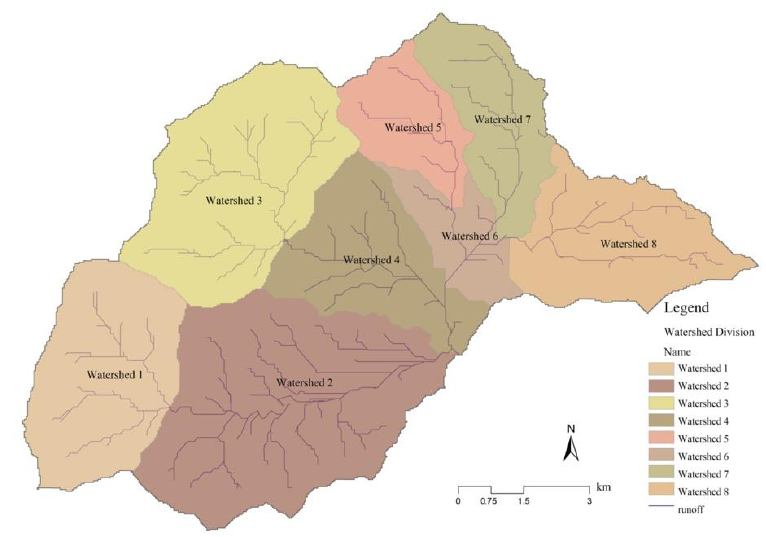
Figure 3. The small watershed of the Shangzhuang Basin.